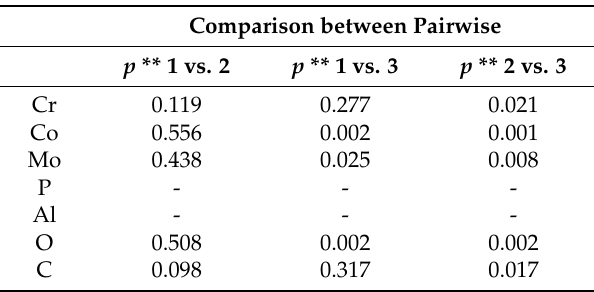
Table 2. Post hoc Mann–Whitney analysis to determine which pairs differed among them (condition numbers: 1-PBS, 2-PBS-HA, and